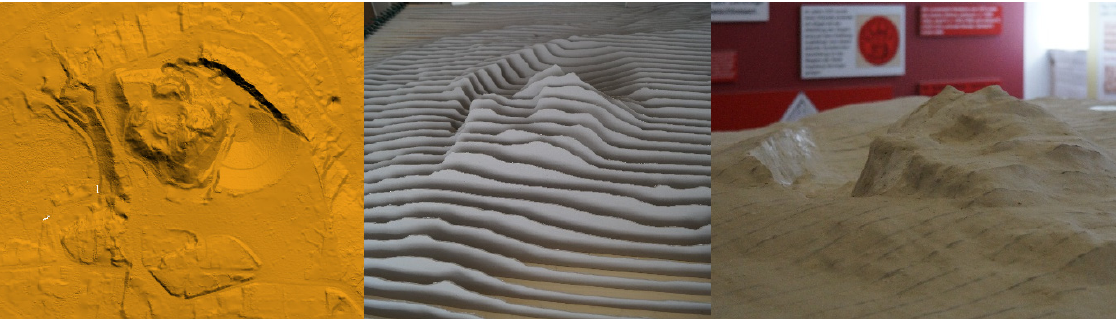
Figure 2. The reconstruction of the Kalkberg from airborne laser scanning data: digital elevation model (original data, left), printed scaled sections of the DEM (centre) and physical 3D model of the Kalkberg at it exists today (right)